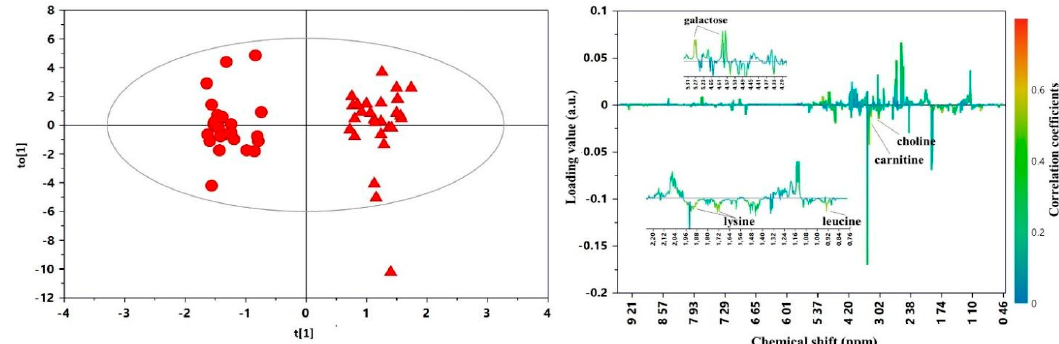
Figure 4. Scores ( left ) and coefficient loadings line ( right ) plots of the OPLS-DA model built with samples collected after 21 days (T1) of ADJ fortification: ● , B-HMF; ▲ , DHMF. Statistical parameters of the models: R 2 Y = 0.950; Q 2 = 0.576; p <0.005.